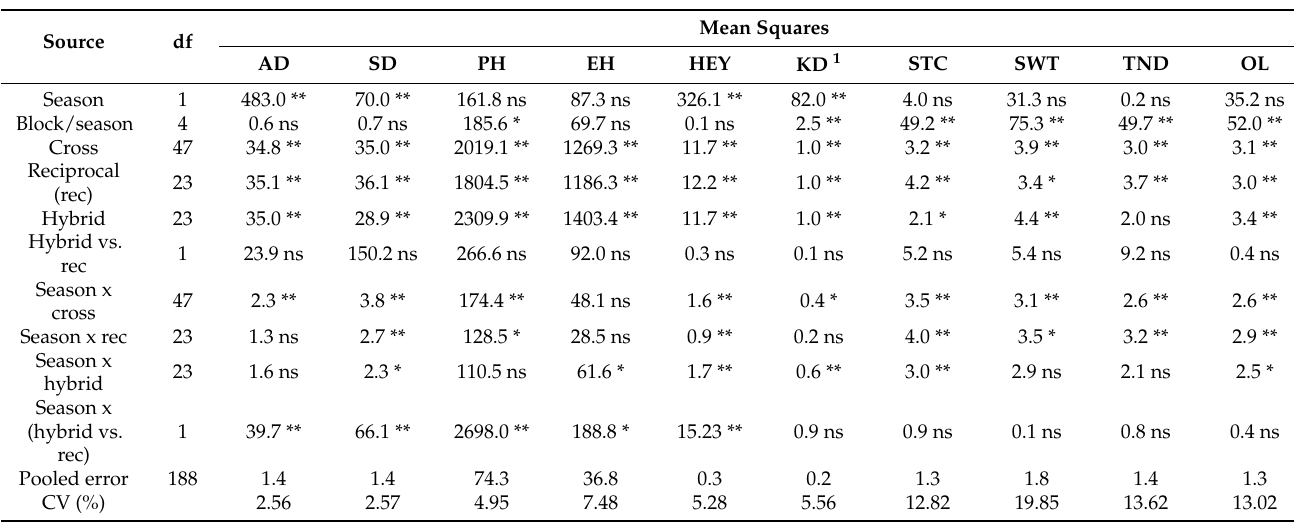
Table 3. Combined ANOVA for grower and consumer preferences including AD (anthesis date), SD (silking date), PH (plant height), EH (ear height), HEY (husked ear yield), KD (kernel depth), STC (stickiness), SWT (sweetness), TND (tenderness), and OL (overall liking) of 48 sweet-waxy corn